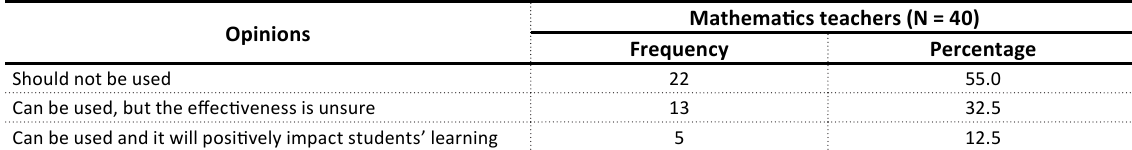
Table 9. Tea chers’ opinions about the use of M-learning for students’ self-study of